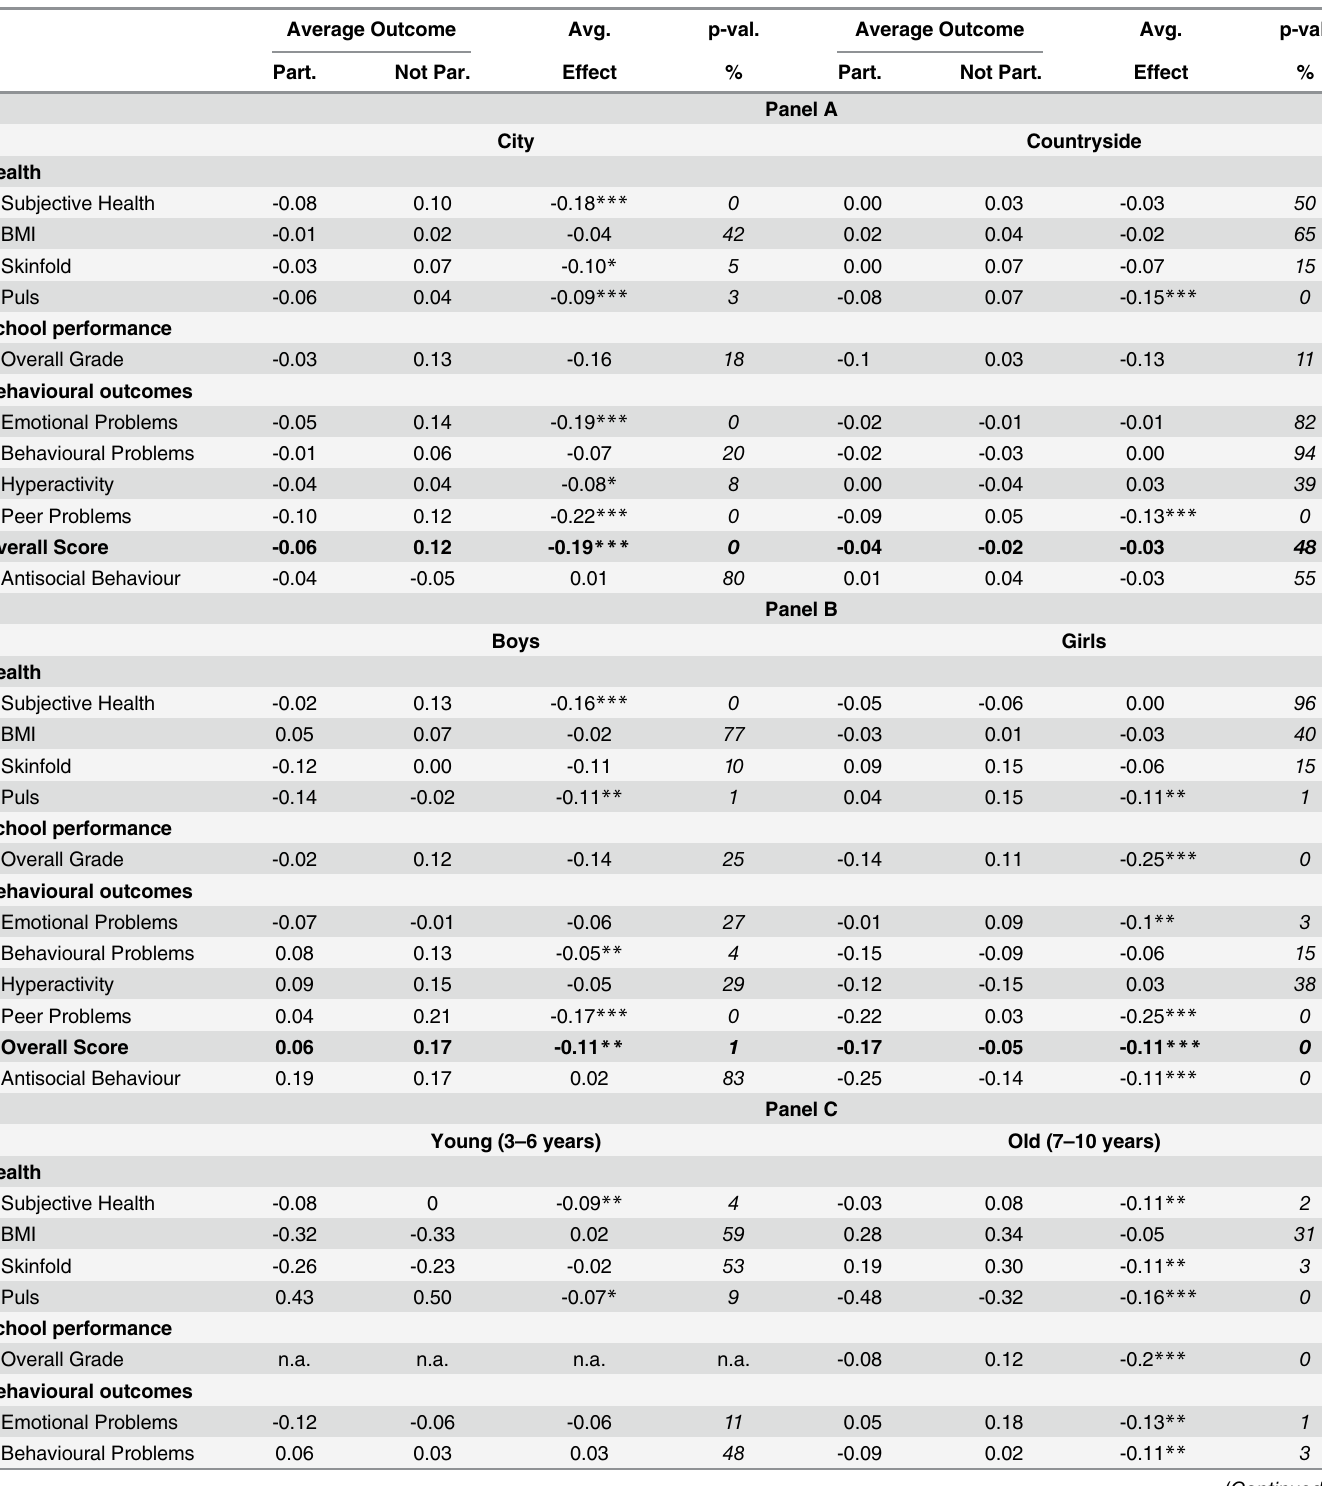
Table 8. Heterogeneity with respect to other characteristics. Note: The distinction between city and countryside is based on INKAR and is a combination of population size, density, political and administrative relevance, etc. The presented effect is the average treatment effect (ATE). P-values are computed by bootstrapping p-values of the t-statistic with 4999